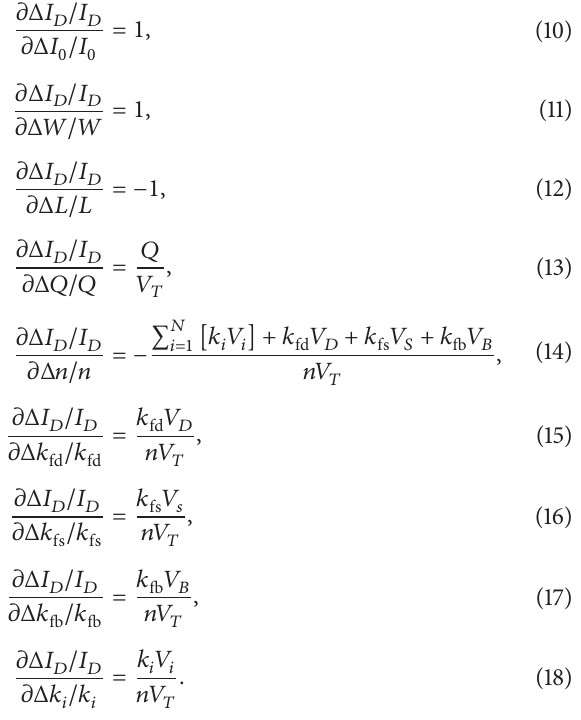
Figure 3: N-type and P-type subthreshold FGMOSFET based comparative plots against |𝑉 1 | where |𝑉 2 | = 0 .